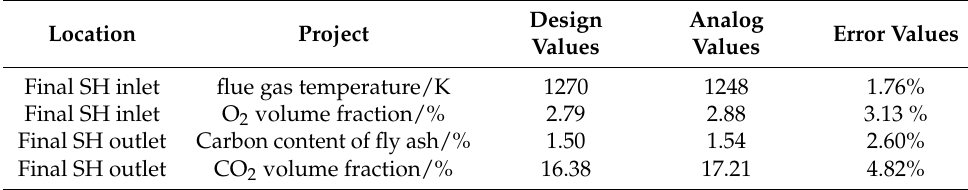
Table 6. Simulation value and design